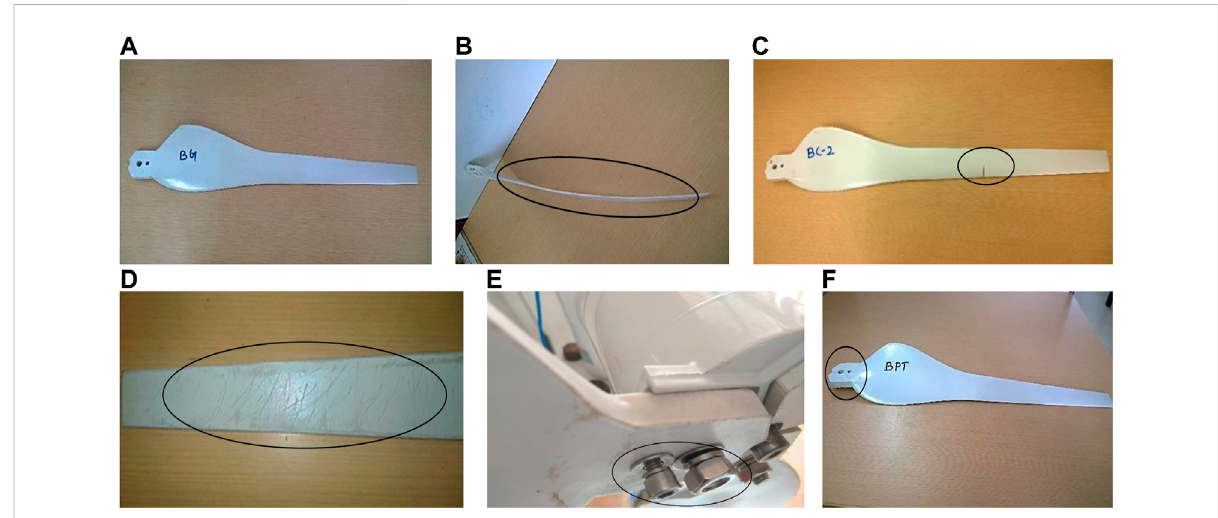
FIGURE 7 (A) Vibration plot for good condition blade. (B) Vibration plot for blade bend fault. (C) Vibration plot for blade crack fault. (D) Vibration plot for blade erosion fault. (E) Vibration plot for hub-blade loose fault. (F) Vibration plot for blade pitch